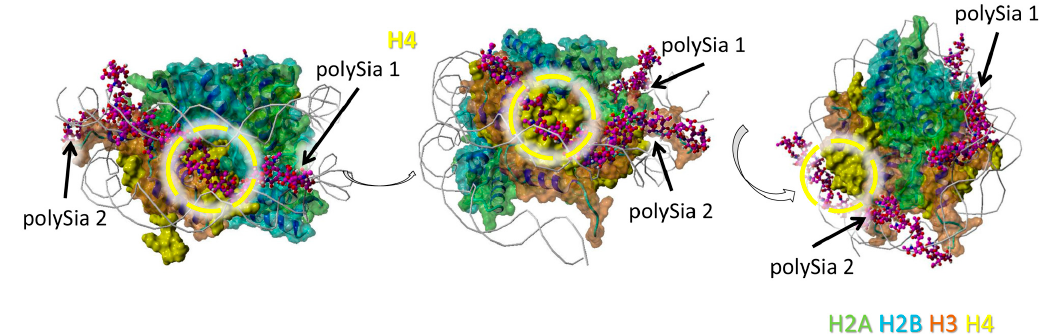
Figure 4. Model of interaction between polySia and H4. The model was generated as described in Figure 1. Color-code: H2A—green, H2B—cyan, H3—orange, H4—yellow, polySia—purple, DNA—gray (as cords). Potential binding areas are highlighted by dashed circles for the histones. The numbered polySia chains are indicated by arrows. The model is shown from three different perspectives (rotated as shown by the open arrows).